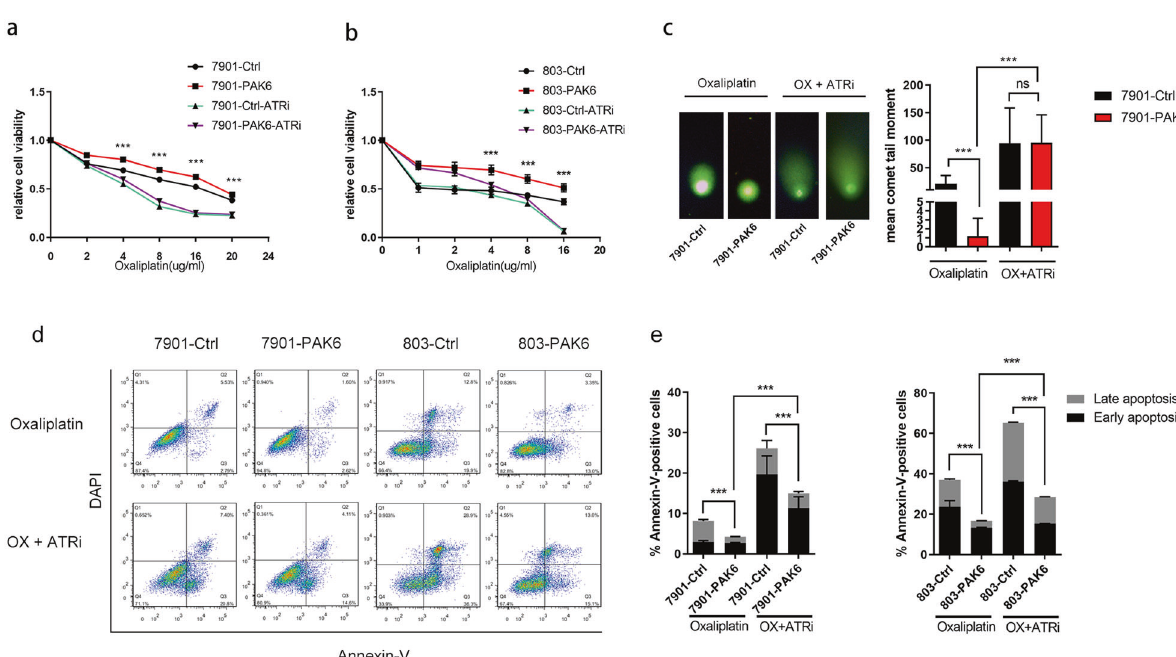
Fig. 6 ATR inhibitor AZD6738 combinates with oxaliplatin could re-sensitize PAK6 overexpression GC cells to oxaliplatin. a , b Dose- response curves of control cells or PAK6 overexpression cells in 7901 ( a ) and 803 ( b ) GC cell line after treated with oxaliplatin or combination of ATR inhibitor AZD6738 and oxaliplatin for 24 h. Data presented as mean ± SD of three independent replicates. c Left: Representative images of neutral comet assays of control cells and PAK6 overexpression cells in 7901 GC cell lines in the presence of oxaliplatin or combination of ATR inhibitor AZD6738 and oxaliplatin; Right: Quanti fi cation of the percentages of DNA tail moments. At least 30 cells per group were included for the counting and quanti fi cation. d Apoptosis analysis of control cells and PAK6 overexpression cells in 7901 and 803 GC cell lines in the presence of oxaliplatin or combination of ATR inhibitor AZD6738 and oxaliplatin. e The percentages of apoptotic cells were displayed by the bar chart. Data presented as mean ± SD of three independent replicates. ATRi: ATR inhibitor AZD6738. OX: oxaliplatin. * P < 0.05, ** P < 0.01, *** P < 0.001, ns: no statistical